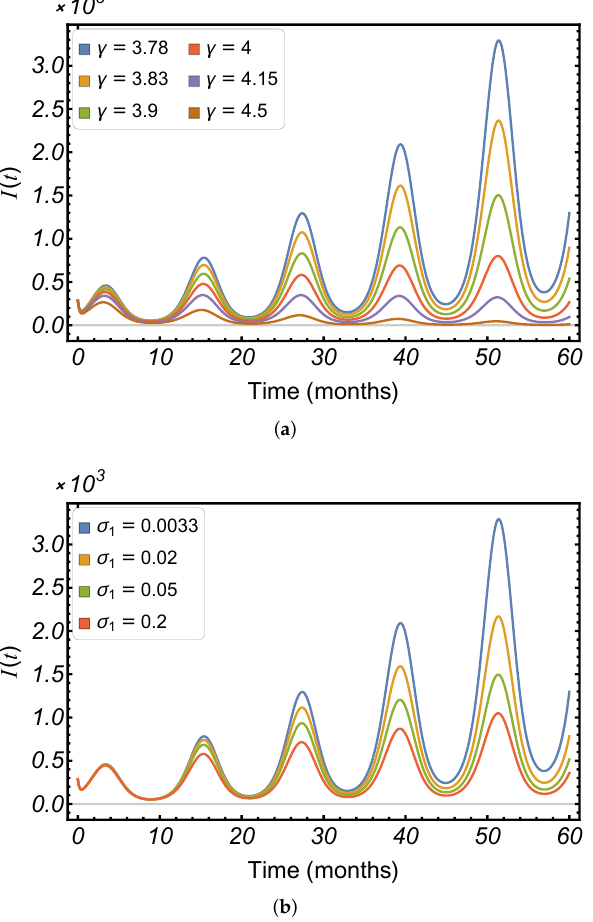
Figure 9. Infectious population with differing values in ( a ) the measles recovery rate γ and ( b ) the second-dose vaccination rate σ 1 , utilizing the parameter values listed in Table 2.